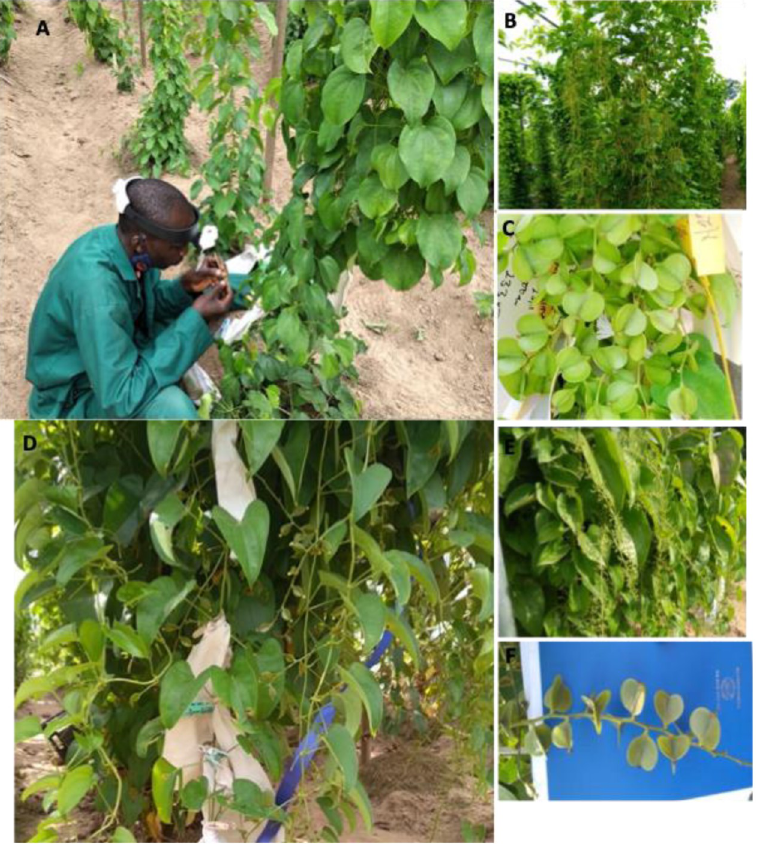
Fig 1. Field pictures of studied yam species. (A) D . rotundata female plant being pollinated using a pin a binocular magnifying glass, (B) D . rotundata male plants at flowering stage, (C) D . rotundata green fruits, (D) D . alata female plant at flowering with some flowers bagged, (E) D . alata male plants at flowering stage, (F) D . alata green fruits. D . alata is characterized by angular stem, high biomass (vigor), and late maturity (~10 months) while D . rotundata has round/circular and thorny stem with hairy tubers and matures in ~8 months.